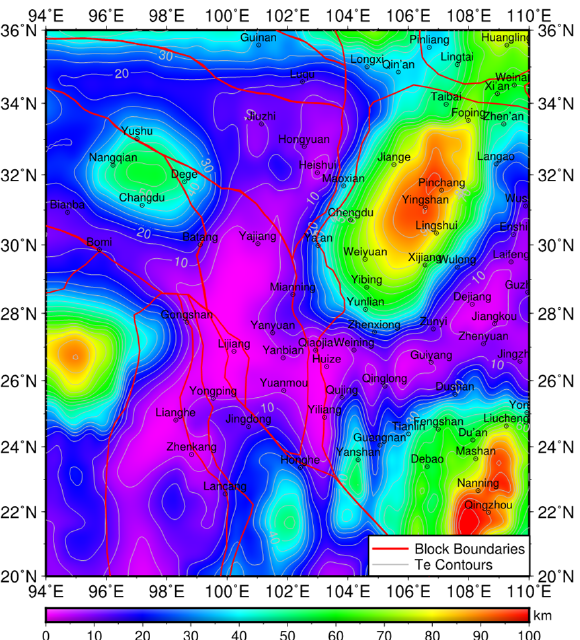
Figure 7. The effective elastic thickness of the lithosphere in the SYR, calculated from the EIGEN6C4 Bouguer gravity anomaly and SIO V15.1 topographic data.